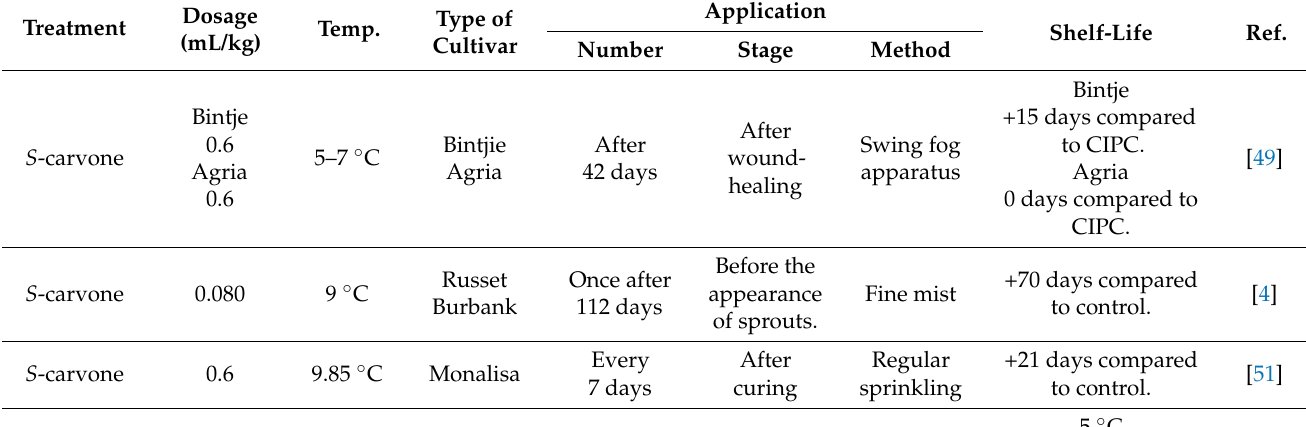
Table 3. Shelf-life studies on different levels of efficacy of S -carvone and Talent TM as sprout suppressants.